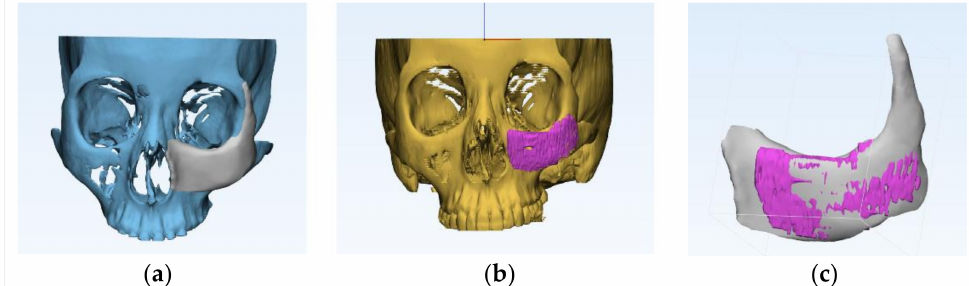
Figure 3. Volumetric analysis between preoperative planned model and actual surgical